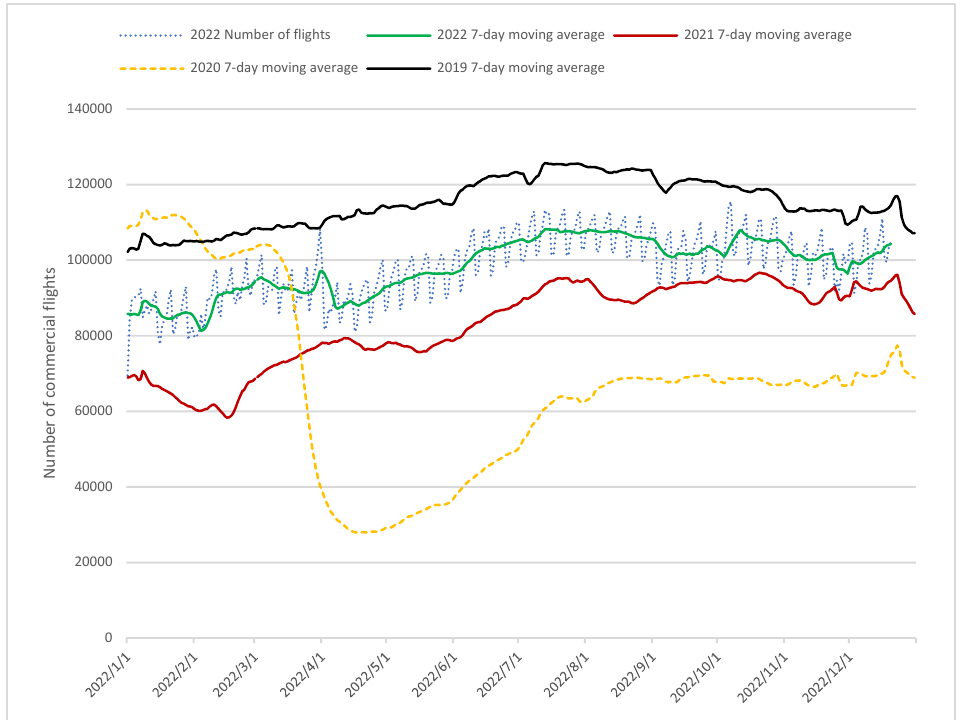
Figure 1. Global Traffic evolution impact and recovery from COVID-19 Source: Author Data from Flightradar24.